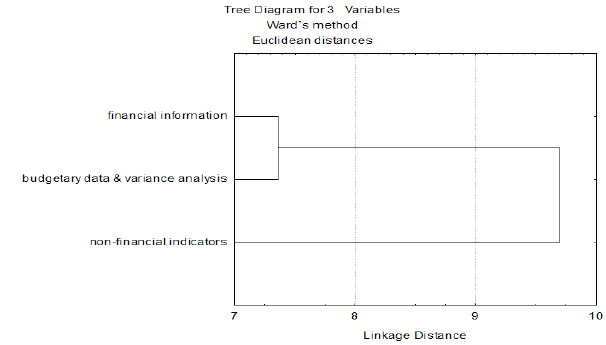
Fig. 5. The assessed suitability of selected